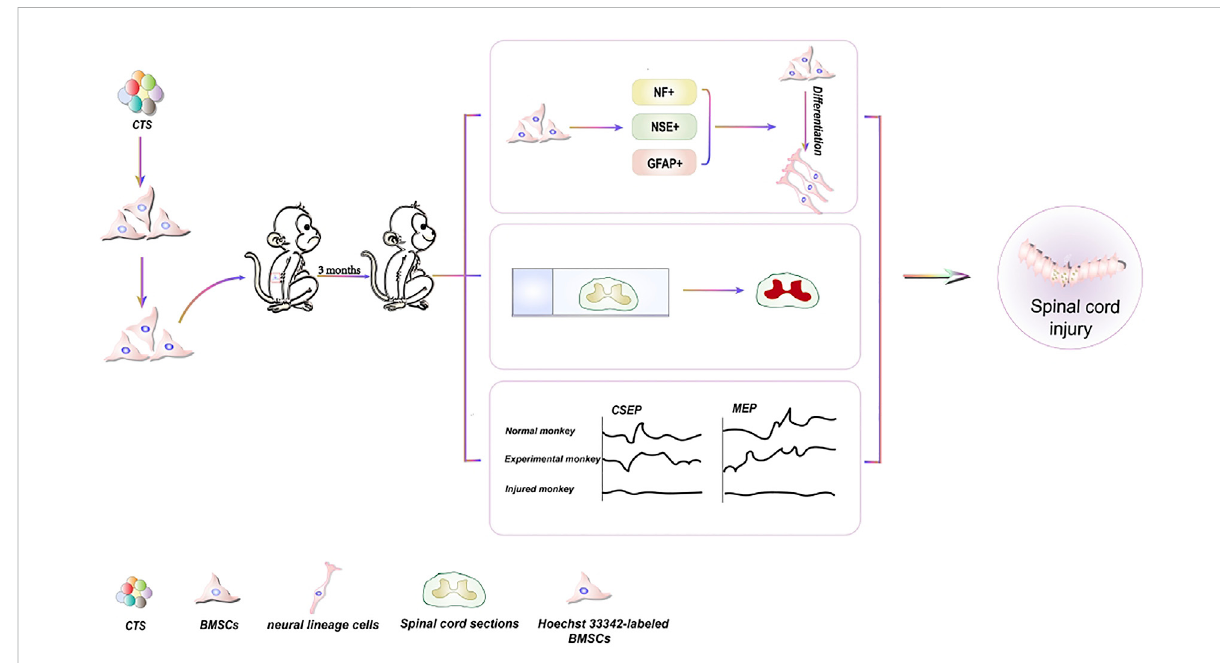
FIGURE 2 Schematic diagrams of the effects of CTS on differentiation of BMSCs for the treatment of spinal cord